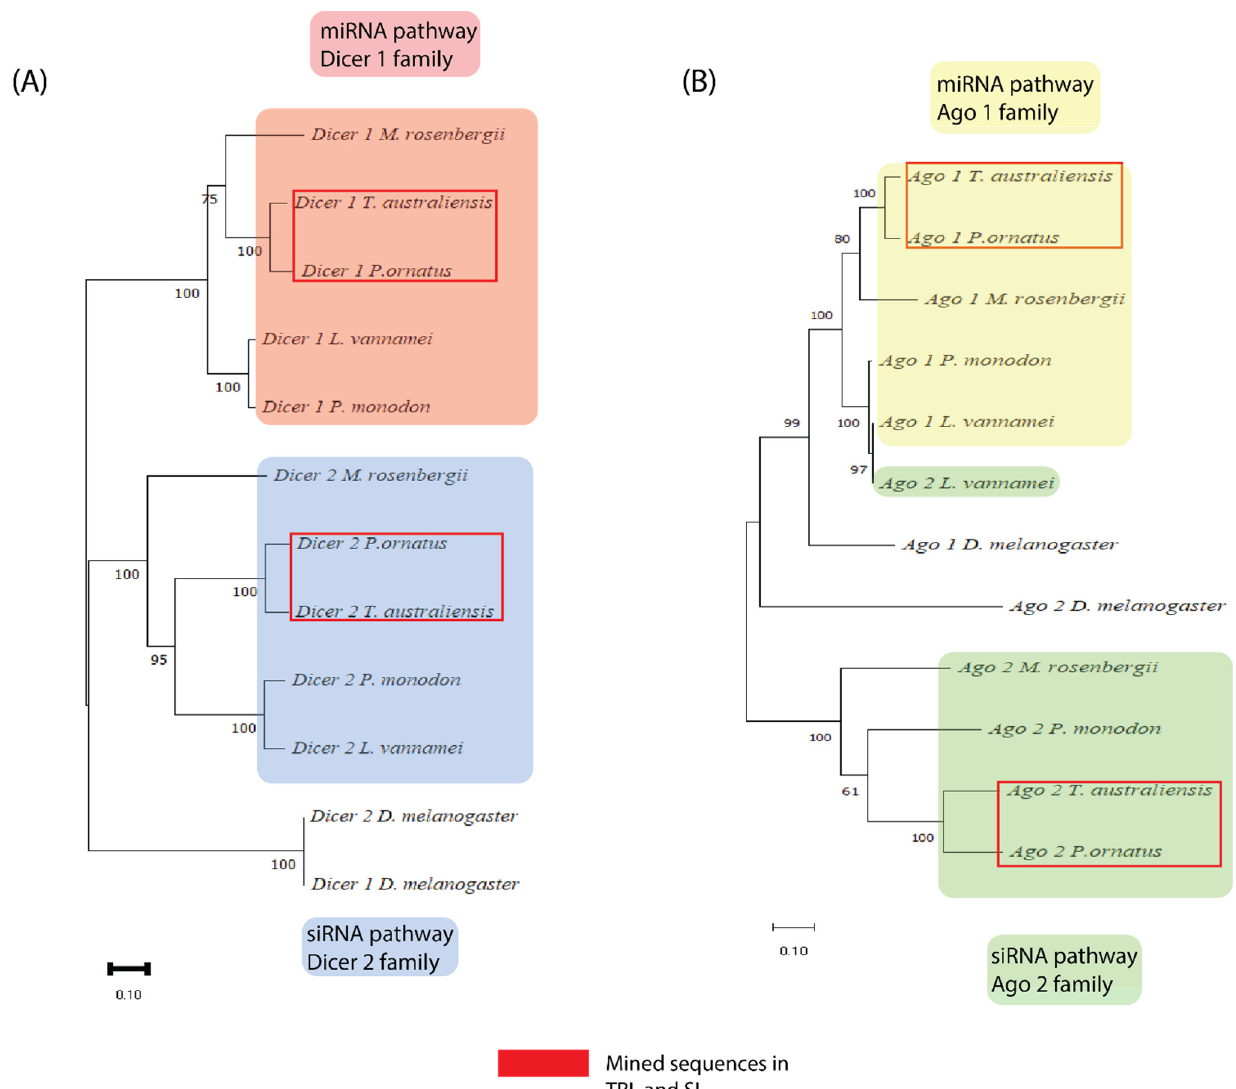
Figure 1. Maximum likelihood tree of putative amino acid sequences of Dicer proteins ( A ) and Argonaute proteins ( B ) from Panulirus ornatus and Thenus australiensis. Sequences for these genes were taken from crustaceans where the RNAi response is better studied (Macrobrachium rosenbergii, Penaeus monodon, and Litopenaeus vannamei) and used to predict the identity of putative transcripts taken from local P. ornatus and T. australiensis databases. The different coloured transparent boxes represent a different group of RNAi genes, and the red boxes represent the putative sequences mined from the local P. ornatus and T. australiensis